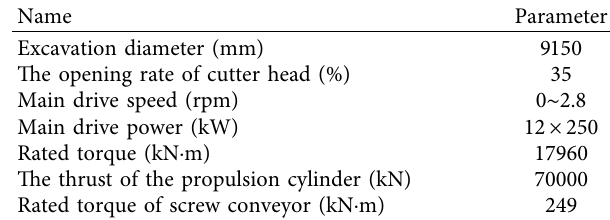
Table 1: Main performance parameters of